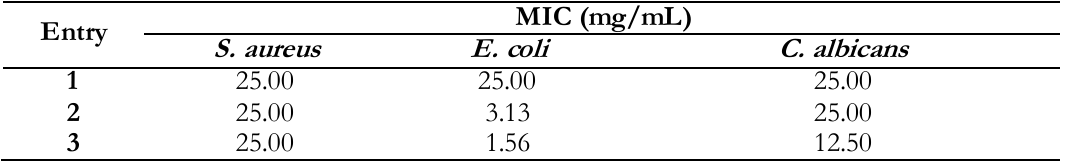
Table I. The in vitro efficiency of inspected compounds 1 – 3 against selected